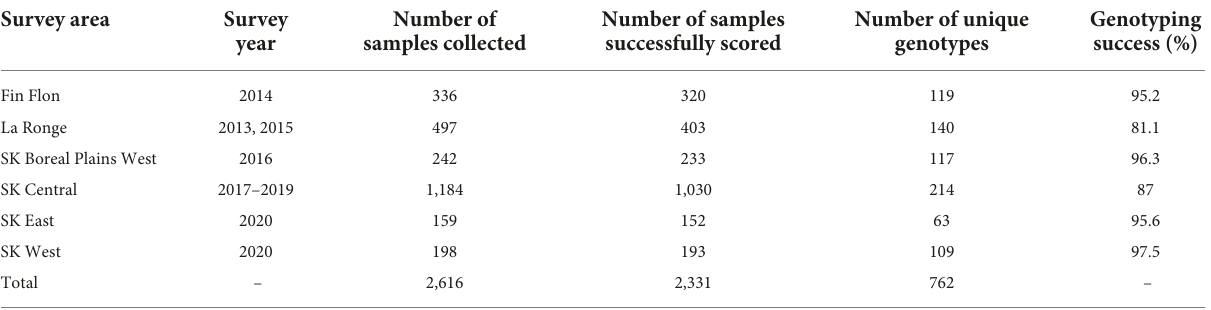
TABLE 1 Fecal pellet sampling data collected from boreal caribou across the boreal plains ecozone in Saskatchewan, Canada. Survey